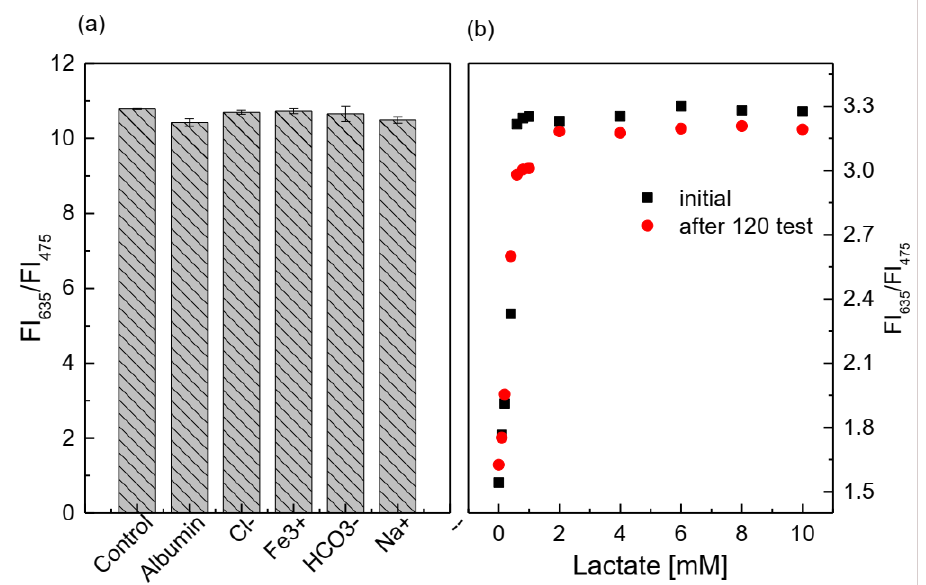
Figure 11. ( a ) Response of the lactate-sensing membrane at 1 mM lactate (control sample), with and without the addition of 145 mM Na + , 106 mM Cl − , 30 mM HCO 3 − , 1.625 mg/L Fe 3+ , and 5 g/dL BSA; ( b ) lifetime of the lactate-sensing membrane at different lactate concentrations. After 120 tests of continuous lactate measurements with the lactate-sensing membrane, the sensitivity of the lactate-sensing membrane was decreased by about 16.7% (Figure 11b). The SIs in the lactate concentration range of 0.1–0.8 mM changed significantly, since the SI varied from SI initial = 2.34 to SI 120test = 1.95. This contributed to the shorter lifetime of LOX than that of